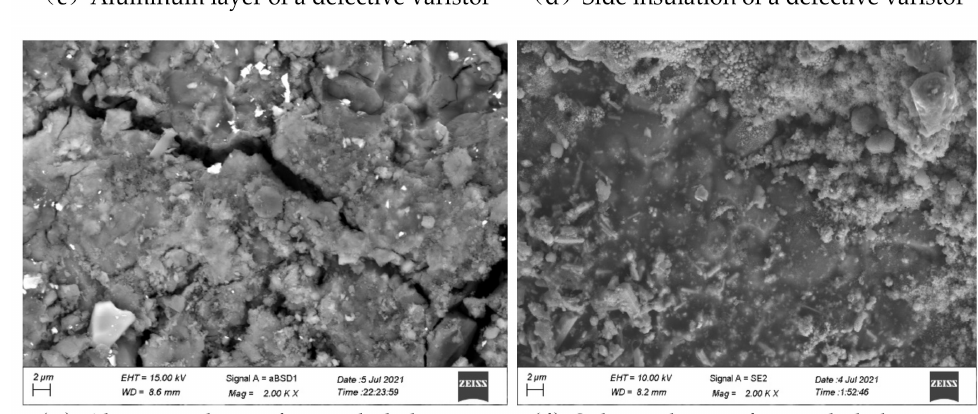
Figure 8. SEM test of arrester